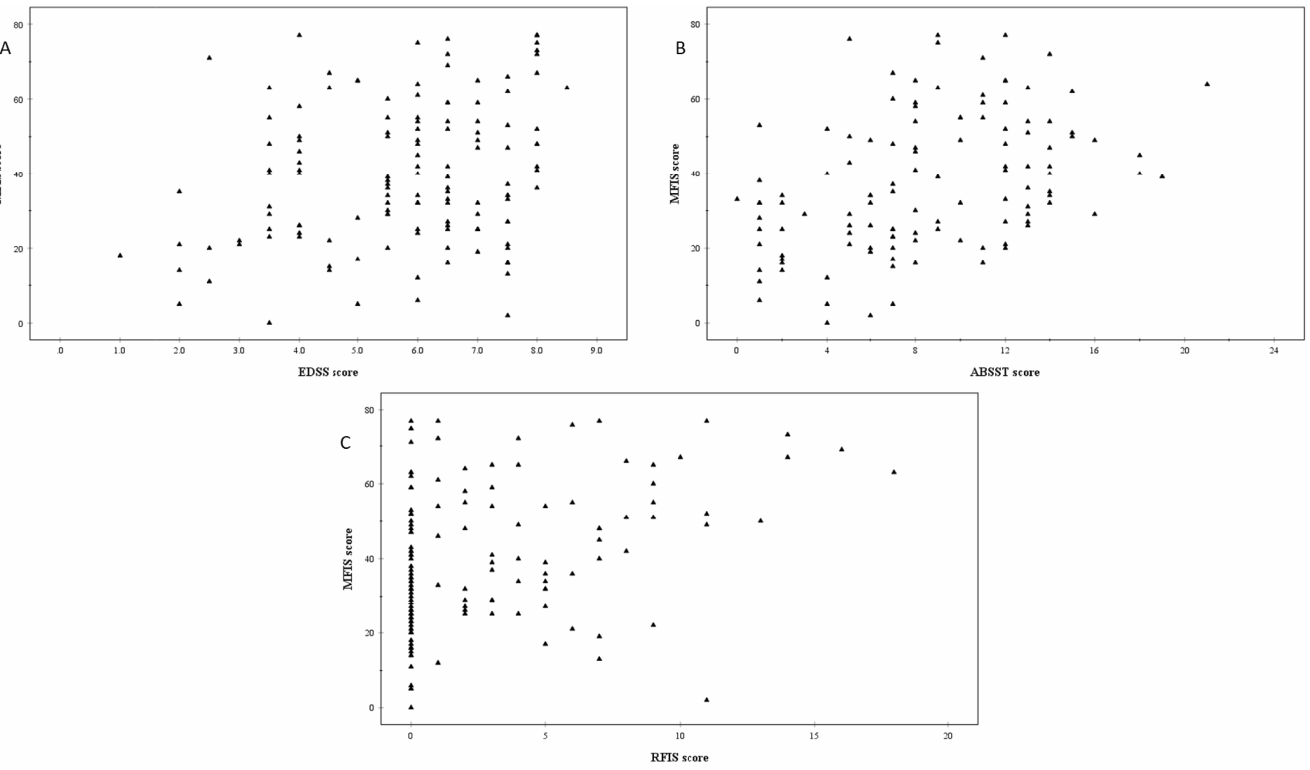
Fig 3. Individual participants’ Modified Fatigue Impact Scale (MFIS) scores plotted against A, Expanded Disability Status Scale (EDSS) scores (n = 135), B, Actionable Bladder Symptom Screening Tool (ABSST) scores (n = 117) and C, Revised Faecal Incontinence Scale (RFIS) scores (n = 135).